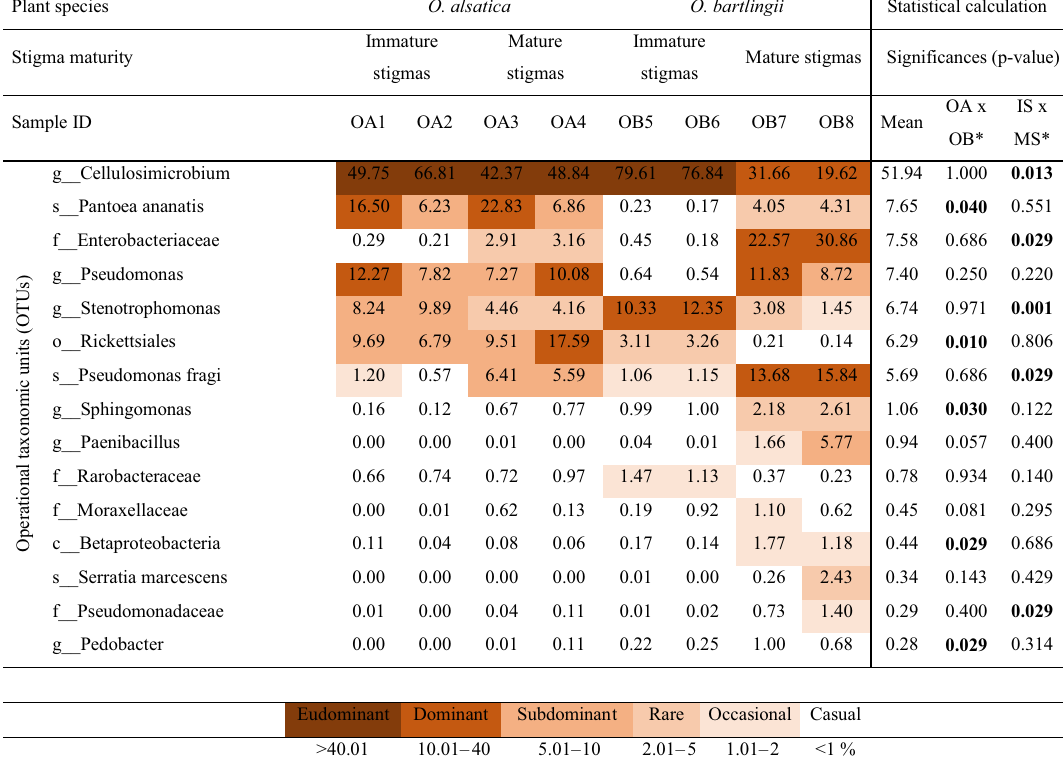
Table 2. Frequency (%) of bacteria identified in Orobanche alsatica (OA) and O. bartlingii (OB) in immature stigmas from closed flowers (1, 2, 5, 6) (IS) and mature stigmas from opened flowers (3, 4, 7, 8) (MS) and statistical calculation. *Only OTUs with significant biological differences ( P < 0.05) were marked. Significant values are in